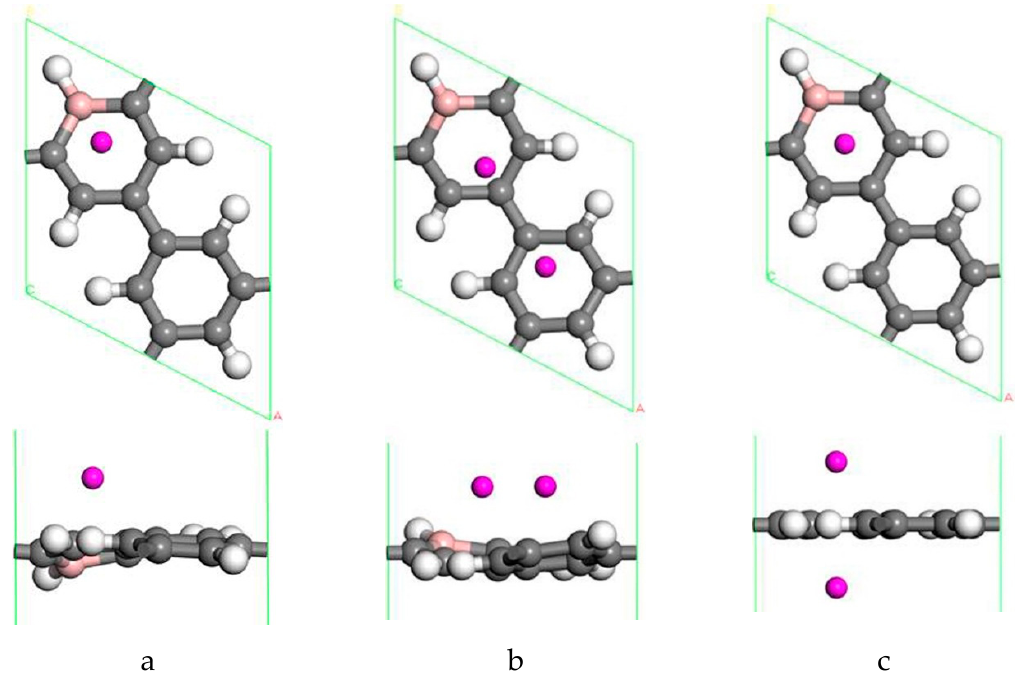
Figure 2. Sc-B / PG system optimized geometry: ( a ) Single Sc atom modification; ( b ) two Sc atoms single-sided modification; ( c ) two Sc atoms double-sided modified in the same pore position. Gray, white, pink, and purple spheres represent C, H, B, and Sc atoms, respectively).